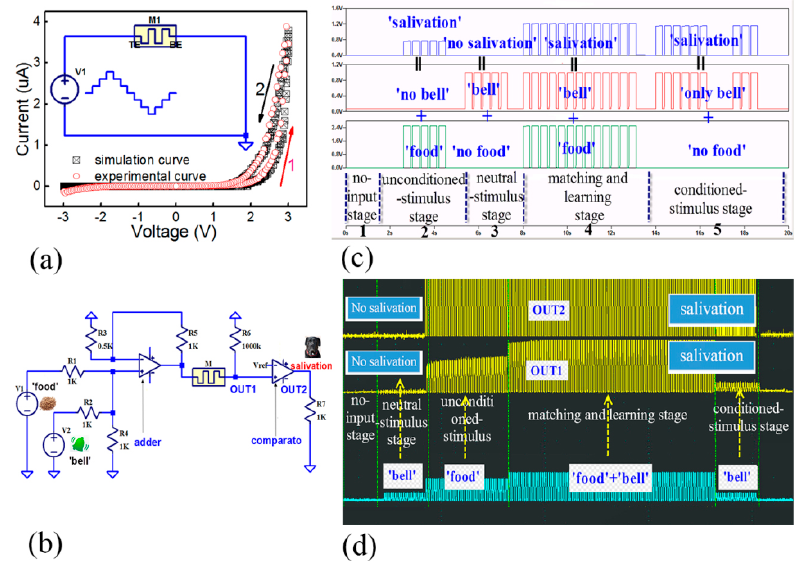
Figure 4. Simulation and experimental results ( a ) Simulation results of the device using the LTspice model; ( b ) Pavlov training circuit; ( c ) Resulting simulation of Pavlov training circuit; ( d ) Physical experiment results. M1 is the memristor and V1 is a step-wave voltage source with 0.05 V voltage-step and 50 ms time interval.